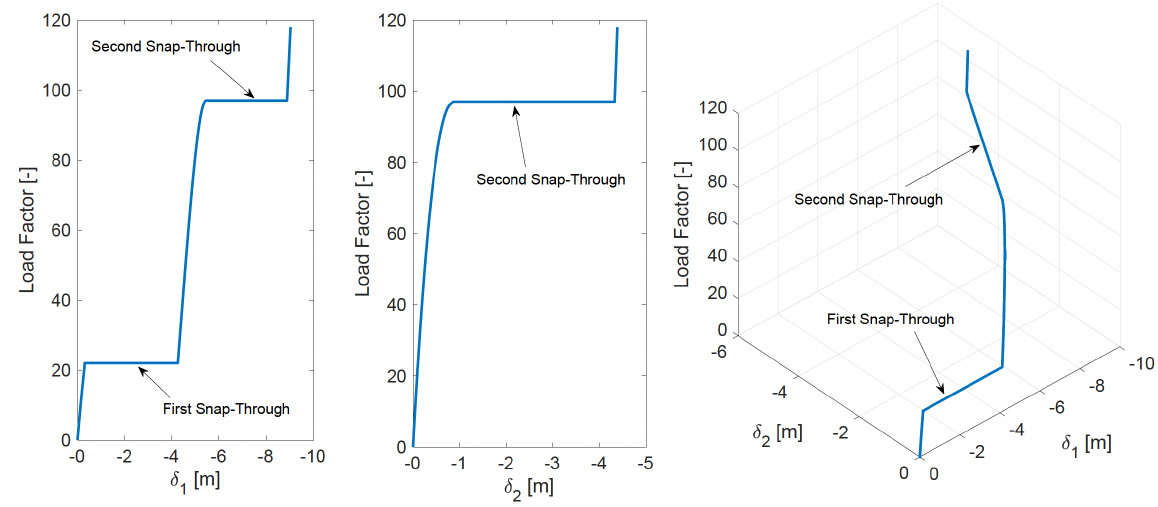
Figure 17: Sixteen-member structure load-displacement curves for increasing load (Case 2)